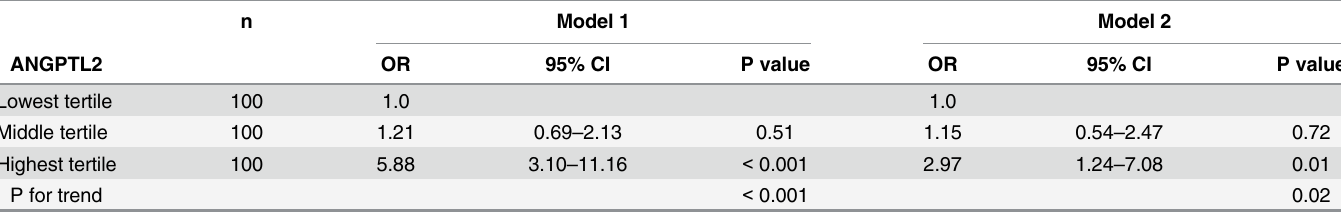
Table 4. Multivariate logistic regression analyses showing the odds ratios (OR) for the presence of heart failure in different levels of circulating ANGPTL2. n Model 1 Model 2